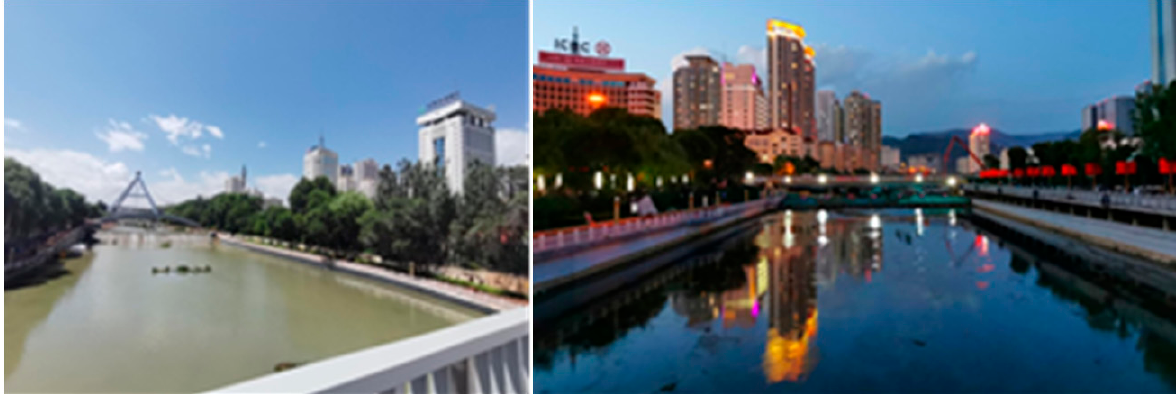
Figure 5. Current Riverside Street View of Xining.